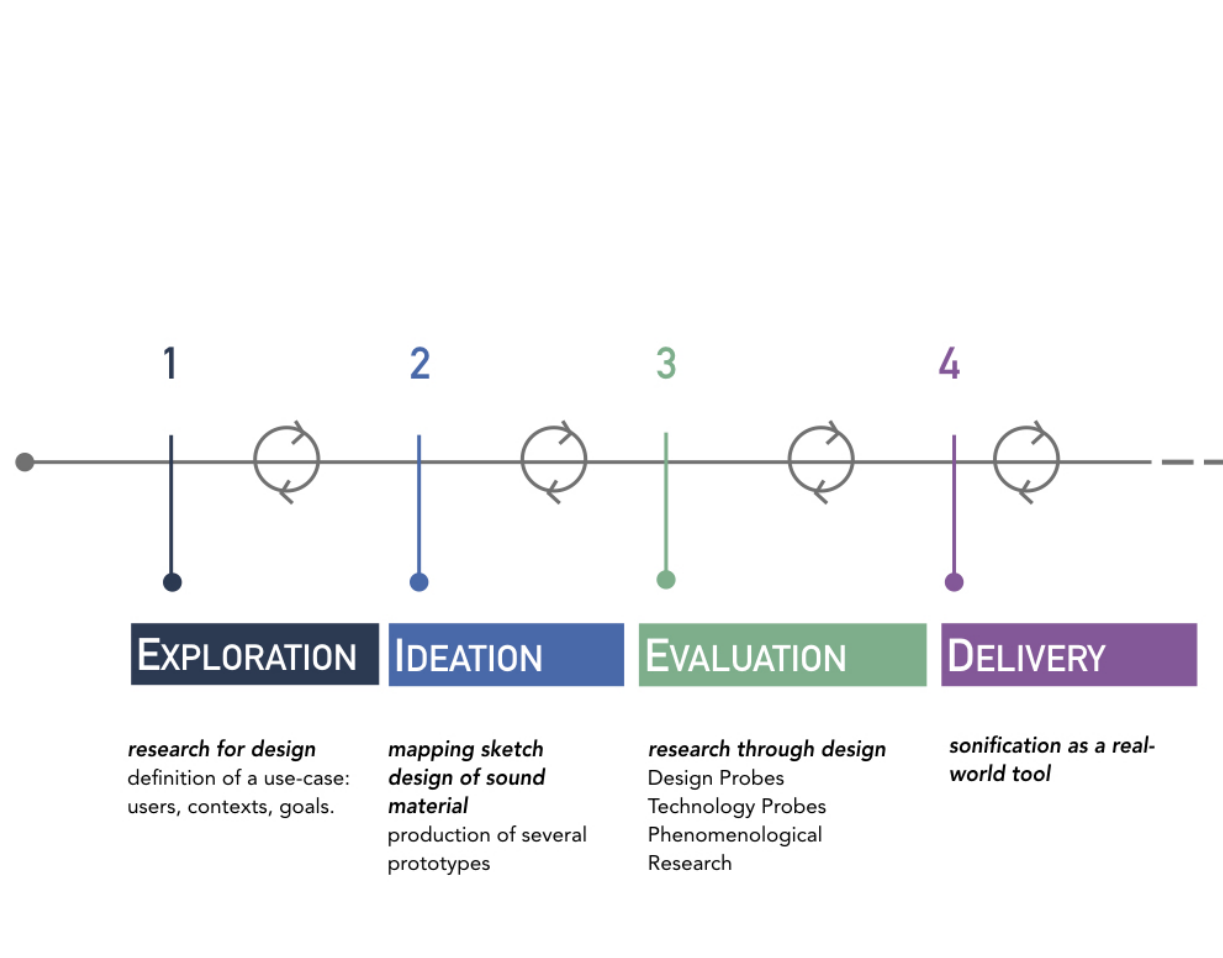
Figure 7. Sonification design process mapping